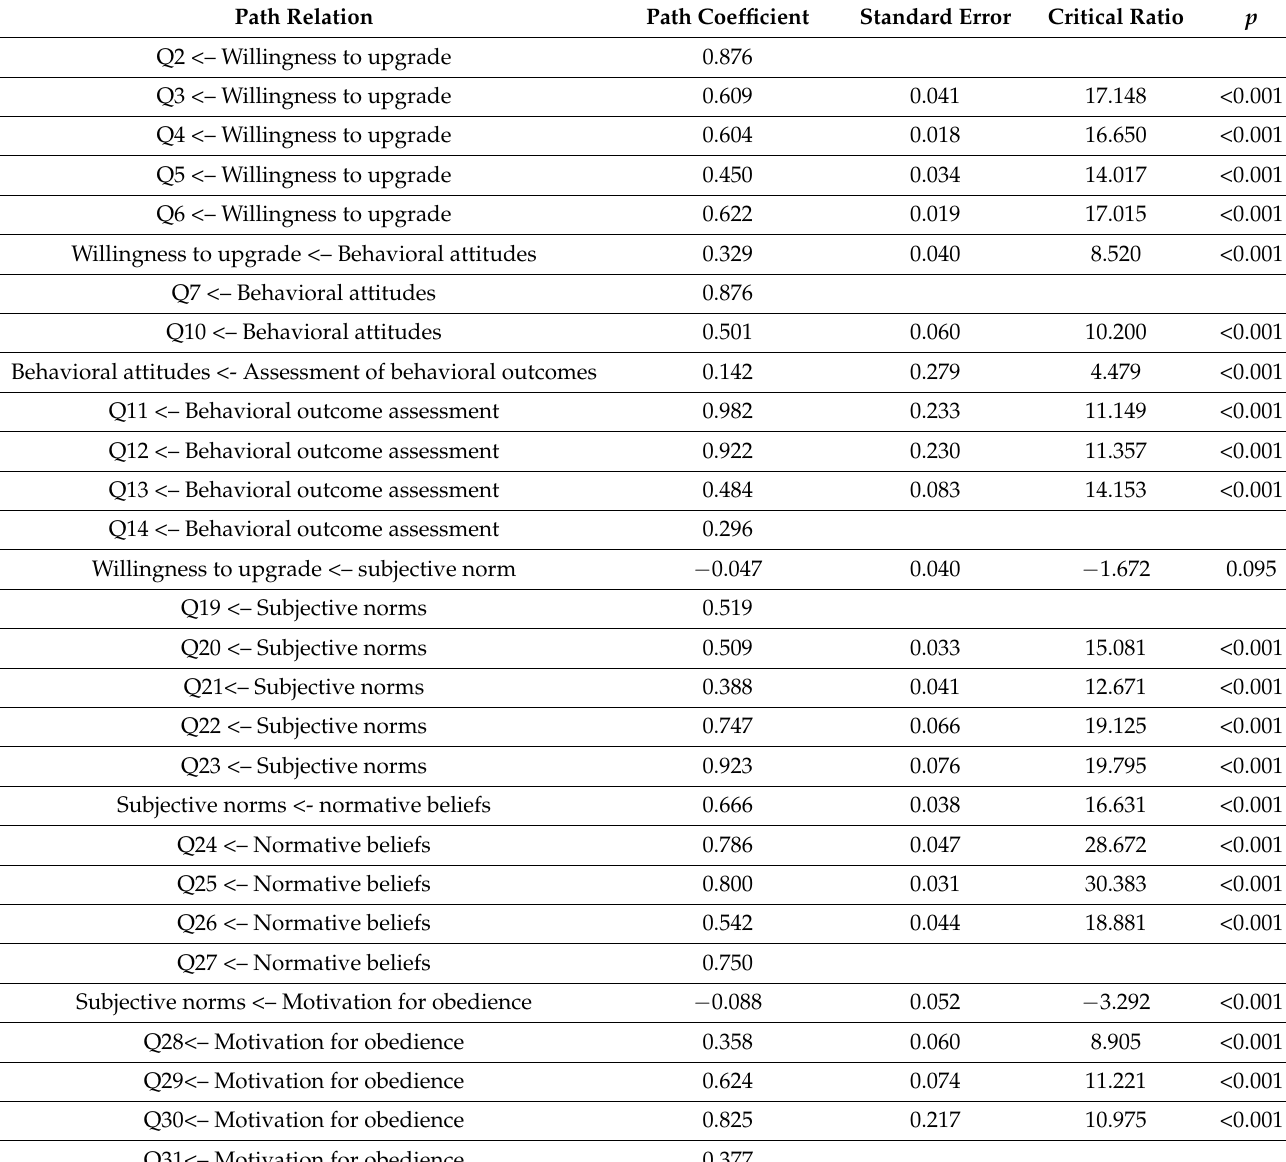
Table 7. Estimated normalized path coefficients for the optimization